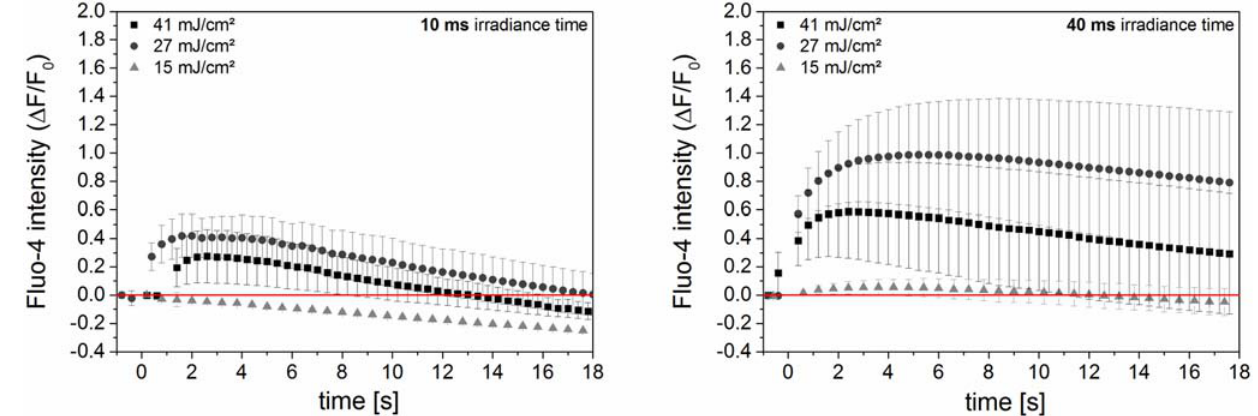
Fig 5. Normalized fluorescence of calcium indicator Fluo-4 after laser perforation. Fluorescence intensity is normalized to the value before laser manipulation. The point in time of laser manipulation was set to zero seconds. The increase of Fluo-4 fluorescence intensity after laser manipulation corresponds to an increase in intracellular calcium, see Fig 7, as well as inflow of extracellular calcium. The process is highly dependent on radiant exposure and irradiation time. Signal decrease below base level is most likely explained by photobleaching. The mean and standard error of three experiments with five irradiated and analyzed cells are